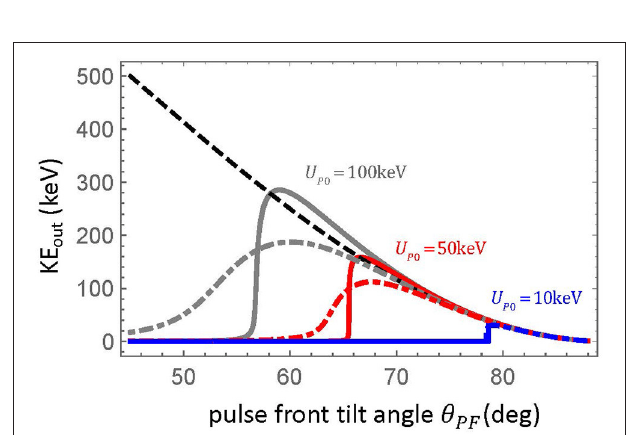
FIGURE 5 | Single particle calculations of output electron kinetic energy KE out resulting from acceleration from a finite Gaussian beam with radius 15 µ m . The pulse duration is either 20fs (solid) or 50fs (dash-dot). The black dashed curve shows the non-relativistic prediction.